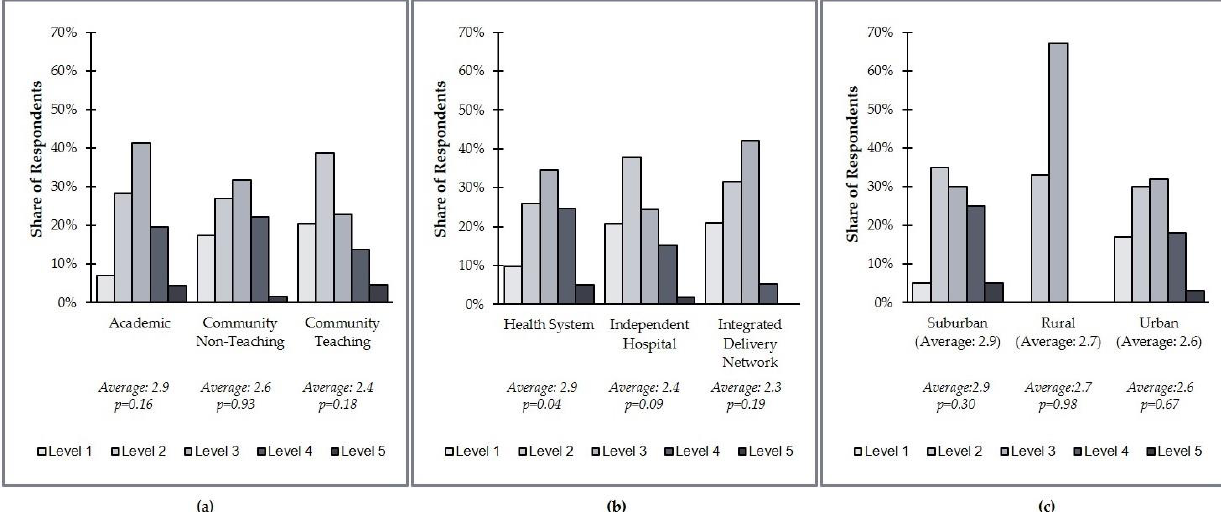
Figure 4. US health system distribution of the overall level of personalized medicine integration by affiliation, practice type, and practice demographics. ( a ) Overall level of personalized medicine integration by affiliation; ( b ) overall level of personalized medicine integration by practice type; ( c ) overall level of personalized medicine integration by practice de- mographics.